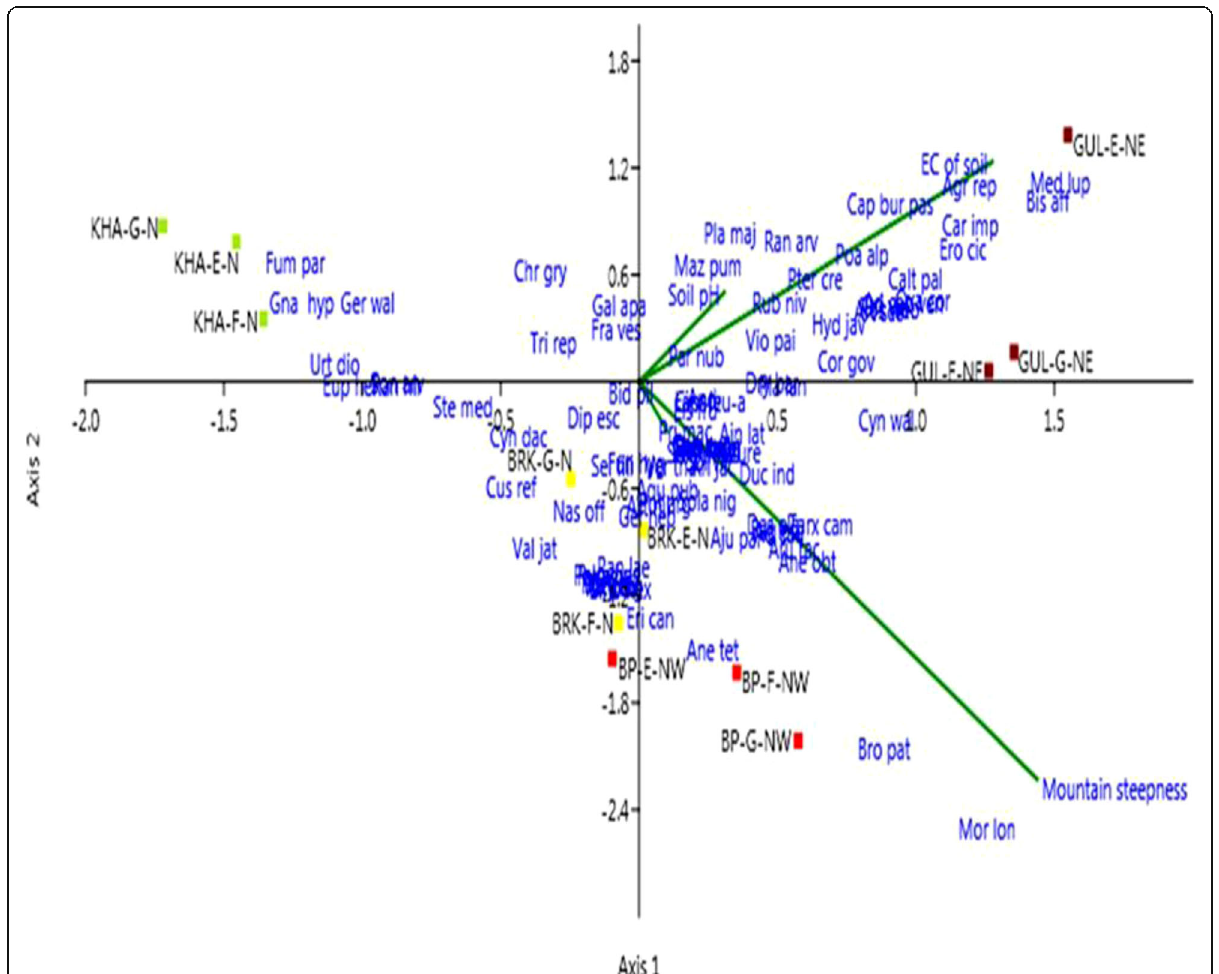
Fig. 4 Triplot of the first and second canonical correspondence analysis (CCA) axis of herbaceous tracheophytes environmental variable and their corresponding sampling sites. Full name for abbreviation codes of herbaceous tracheophytes are given in Additional file 1: Table S1. Site codes: KHA, Khanitop; BP, Below Padhri; BRK, Budh Ro Kut; Gul, Guldanada; G, grassland; E, ecotone; F, forest, N, pure north; NW, north west; NE, north east; and KHA-GN, Khanitop grassland